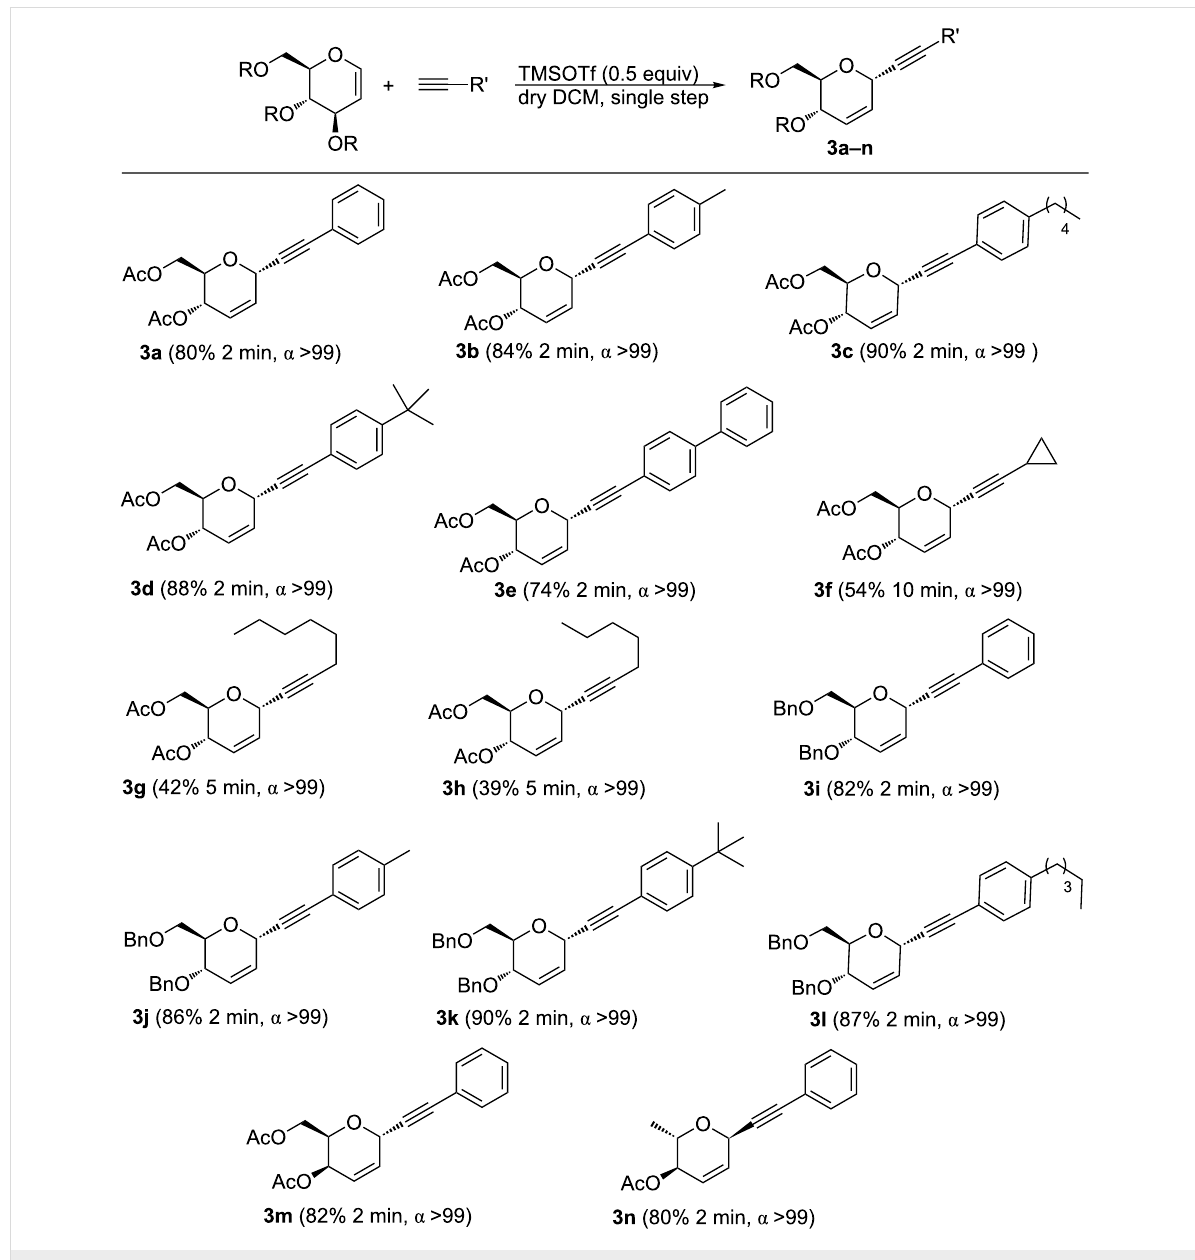
Scheme 2: Substrate scope of the reaction process under optimized reaction